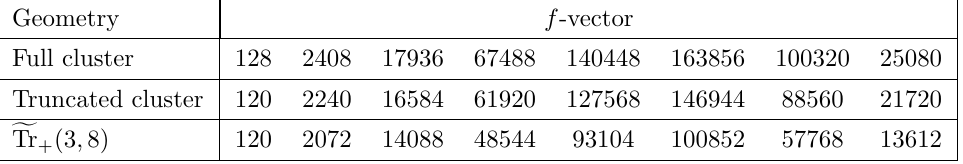
Table 7 . f -vectors of the full and truncated cluster polytope as well as that of f Tr + (3 ;